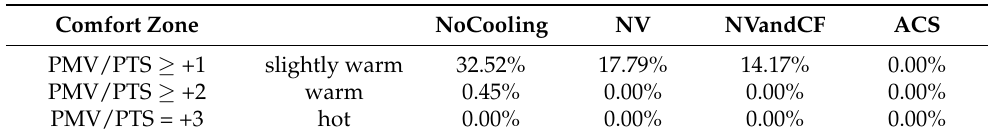
Table 10. Percentage of discomfort hours for different PMV/PTS votes for each cooling concept using the ATHB